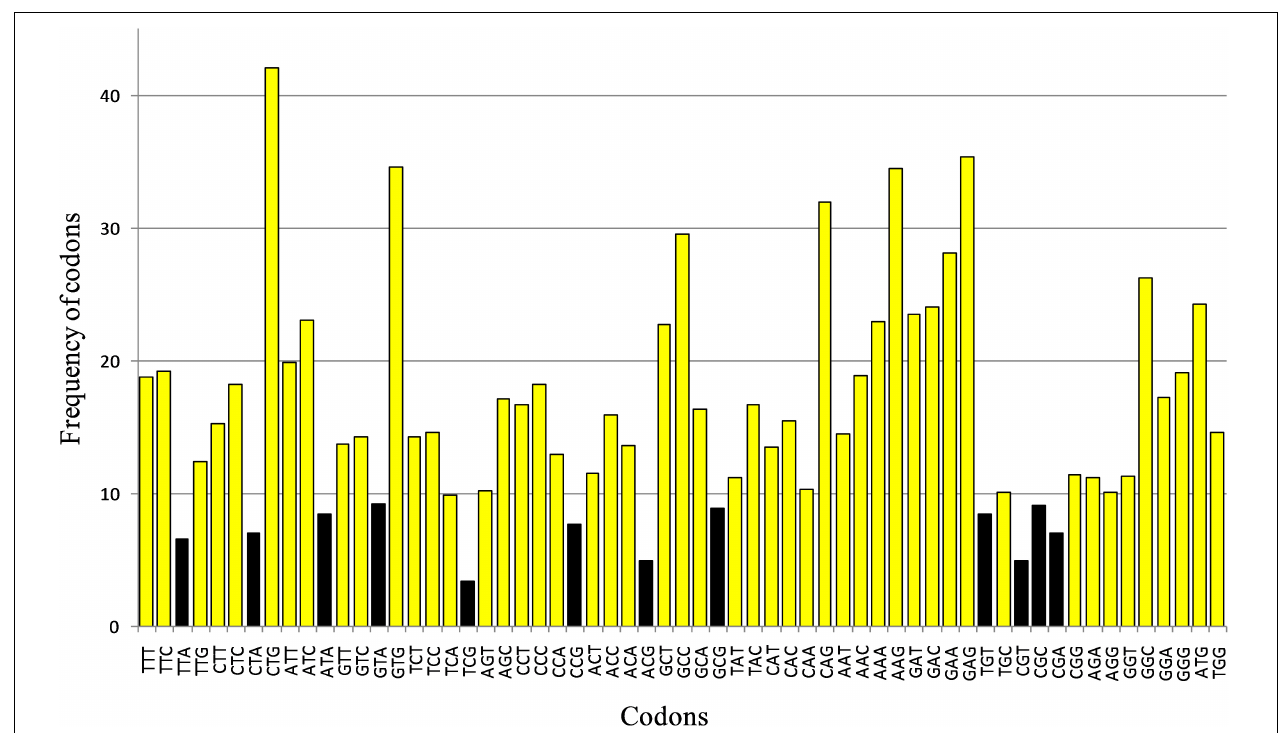
FIGURE 5 | Rare codons for the neurodegeneration associated gene transcripts. The “rare codon” was defined by calculating the frequency of occurrence of all codons in coding sequences (threshold selected < 1% viz. less than 10 in 1,000).